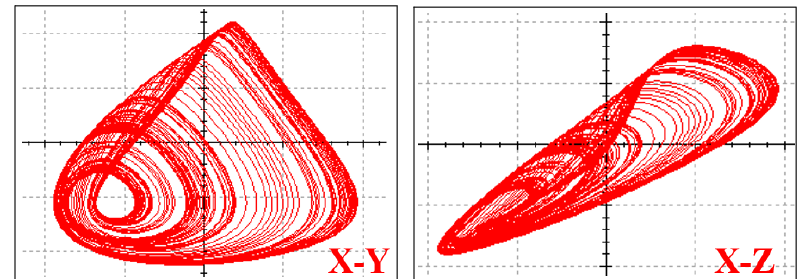
Figure 12. Chaotic attractor in the system (9) from circuit simulation.